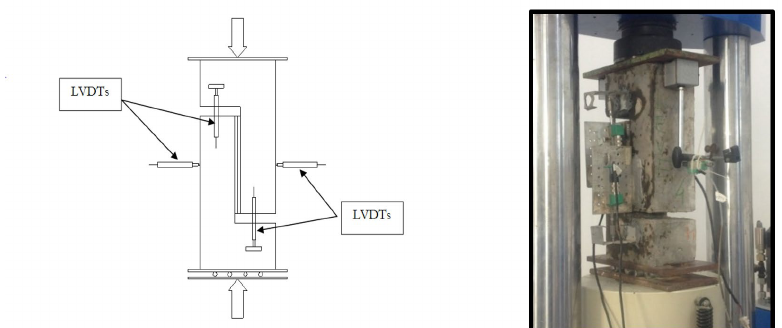
Figure 7. Instrumentation schematic and direct shear testing of push-off specimens [15].